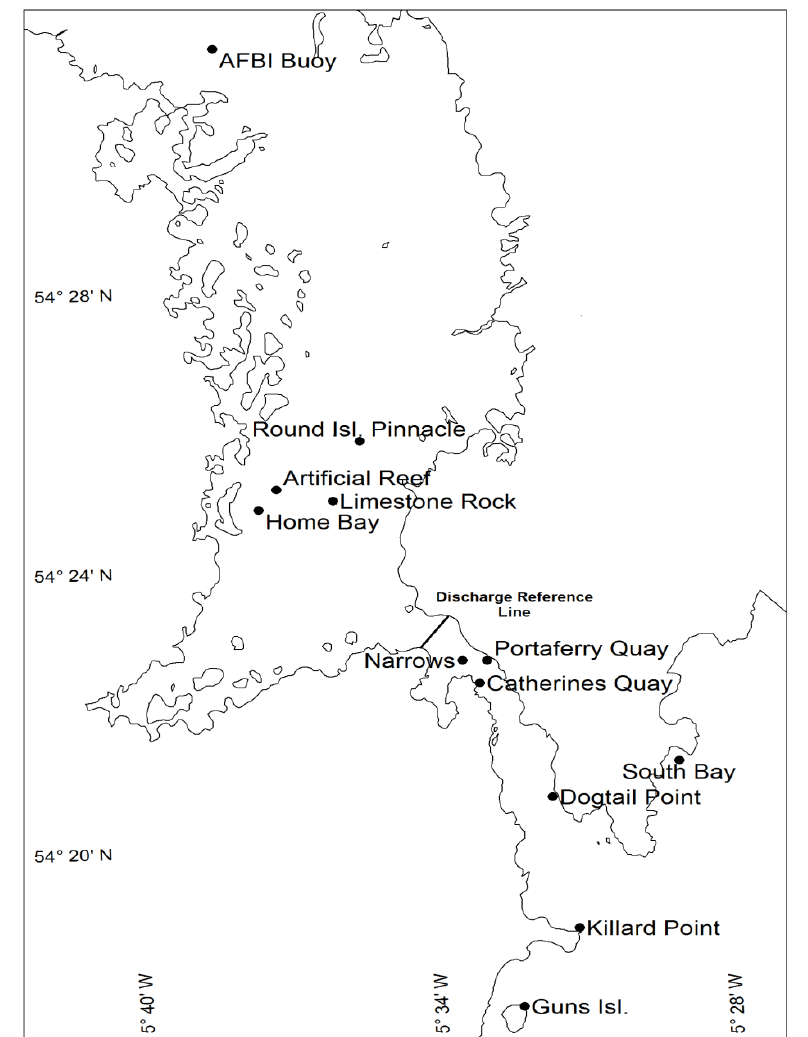
Figure 4. Map of Strangford Lough showing the locations of pressure sensors and current meters used to obtain surface elevation and current data. Location of discharge reference line used to calculate the total water flux is also